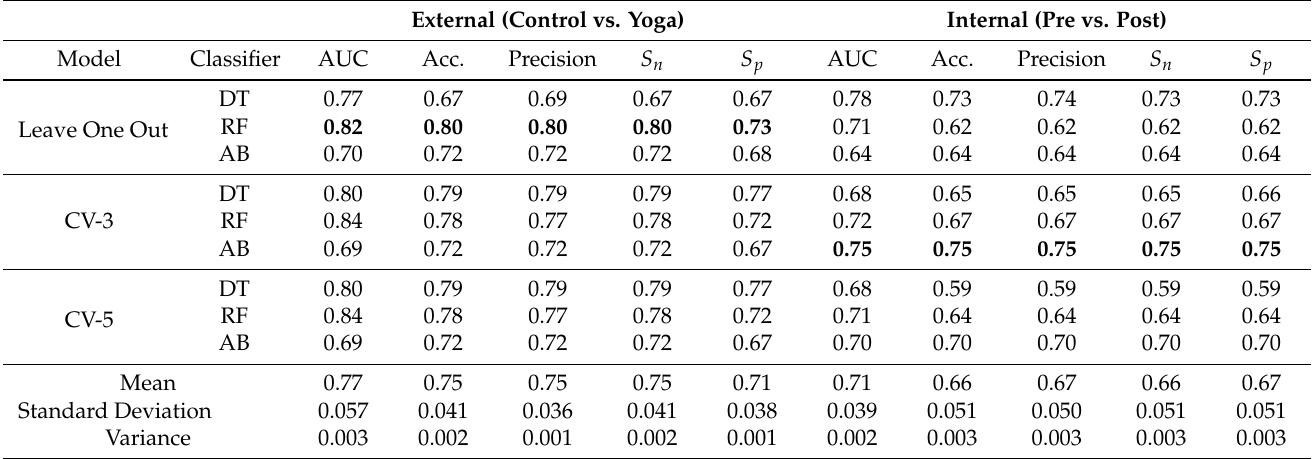
Table 3. Anxiety results of the various performance indicators for internal (pre vs. post) and External (control vs. yoga group). External (Control vs.